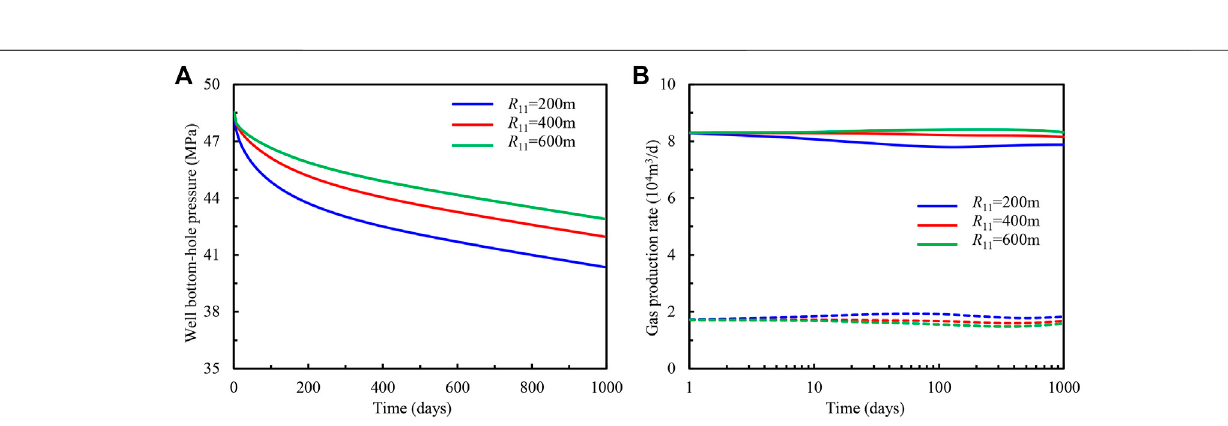
FIGURE 5 | In fl uence of inner region radius for fi rst layer on (A) well bottom-hole fl owing pressure and (B) gas production of individual formation.